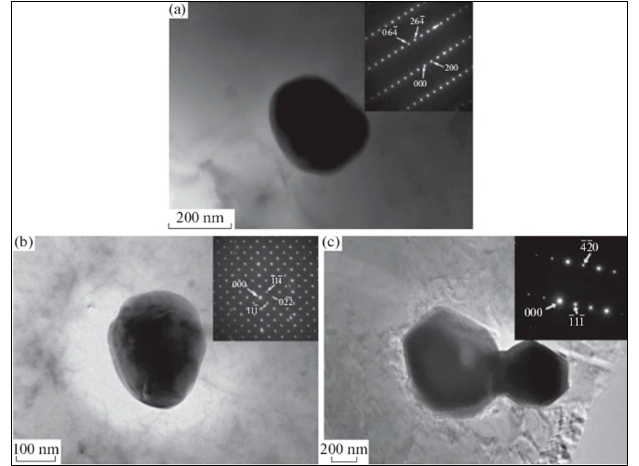
Figure 11. Bright-field image and its SAED pattern of ellipsoid MC carbide particles. ( a – c ) Blocky MC carbide particles (adapted with permission from Ref. [39] 2021, Springer).